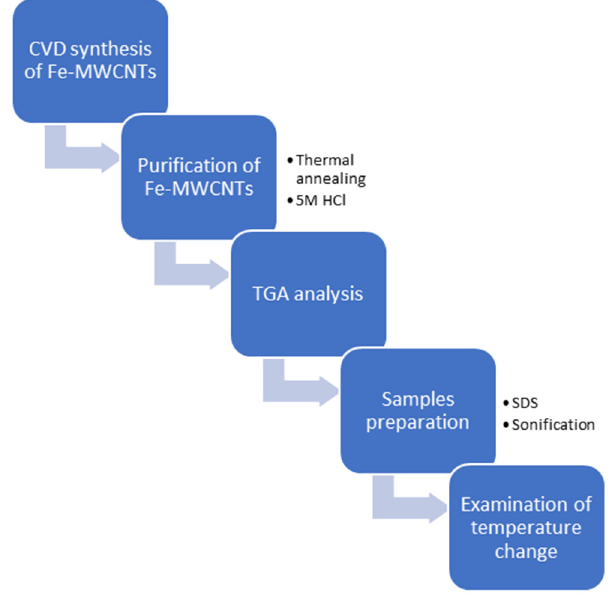
Figure 1. The examination stages diagram.